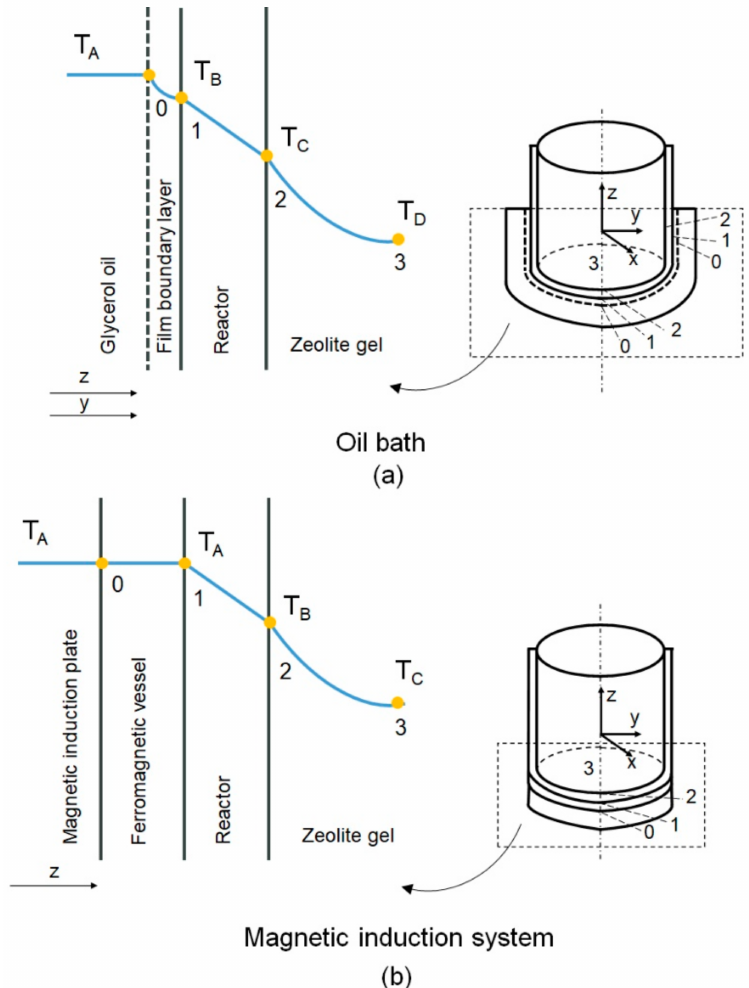
Figure 6. The temperature gradients: ( a ) in the glycerol oil bath heating system; ( b ) in the magnetic induction heating